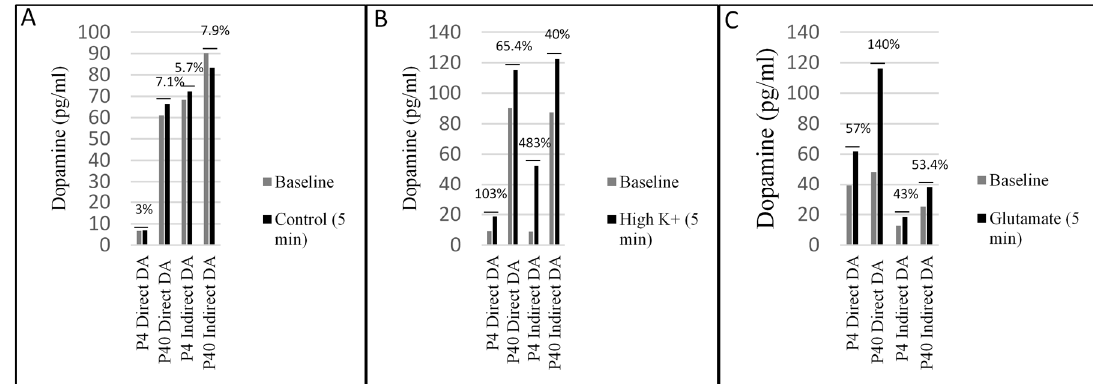
Figure 12. MSCs secrete DA following the DDI and IDI. ( A ) Changes in DA levels (pg/mL) between baseline and control groups. ( B ) Changes in DA levels between baseline and treatment with elevated K + . ( C ) Changes in DA levels between baseline and treatment with glutamate. Varying levels of DA were observed across samples at baseline, suggesting that differentiated MSCs spontaneously release DA prior to treatment with K + and glutamate. Because levels of DA were not consistent across all samples at baseline, it is likely that there were different concentrations of DA secreting-MSCs in each of the three wells prior to collection. In order to show effects of K + and glutamate, data is represented as a percent increase from baseline. Results show an increase in expression of dopamine following treatment with elevated K + and glutamate for all treatment groups.